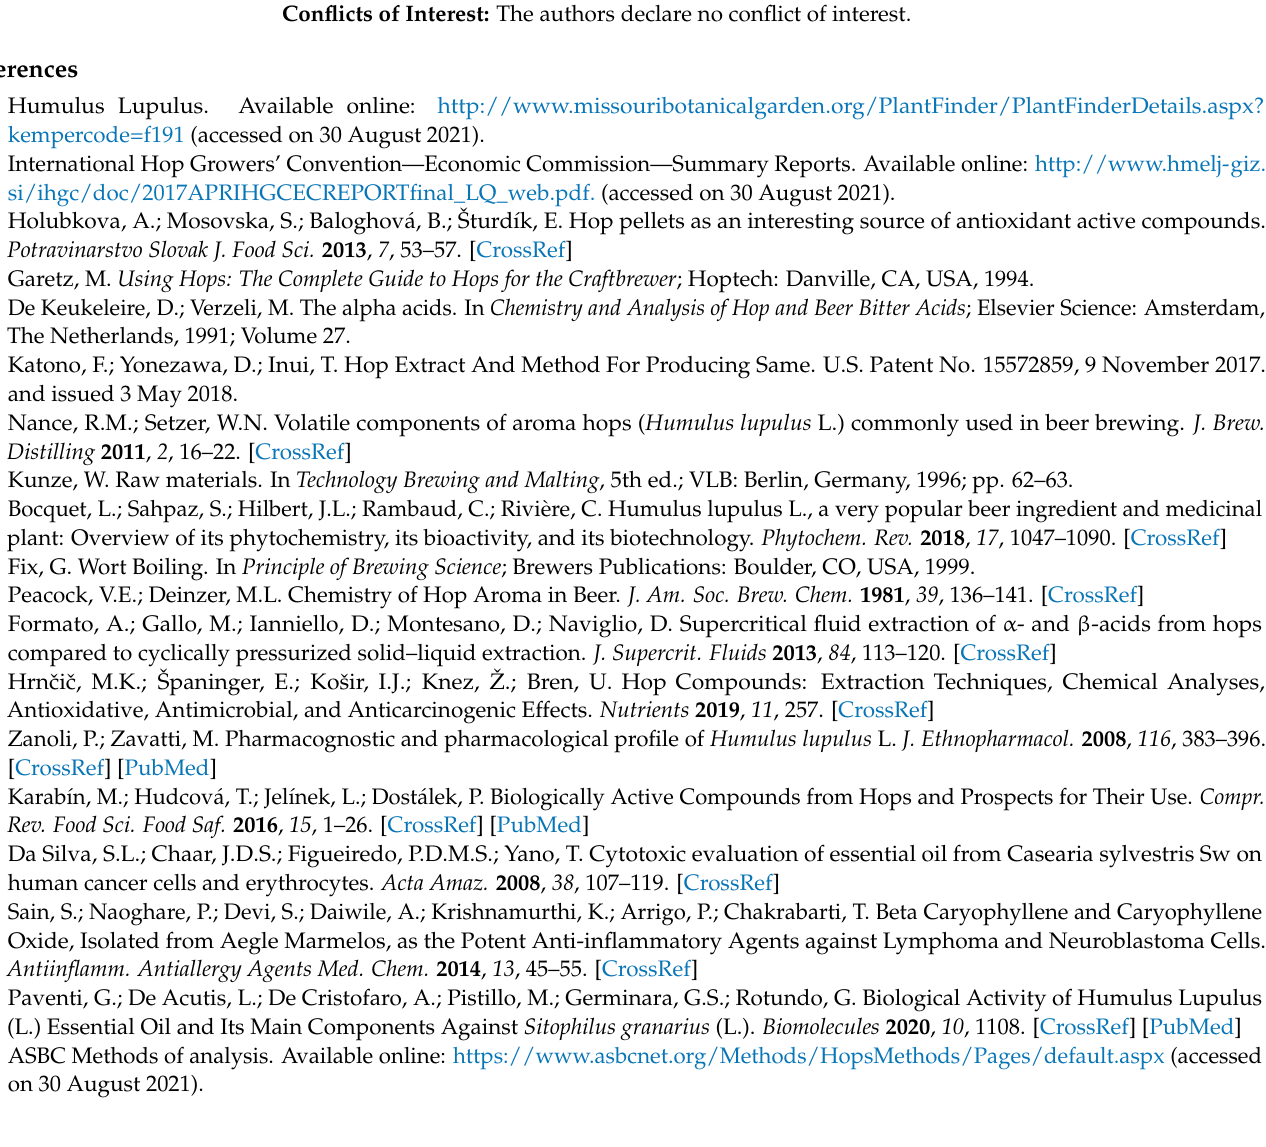
Table S5: MAHD screening summary, Table S6: Energy consumption evaluation. Figure S1: Volatile fraction extraction yields summary, Figure S2: Main terpenoid distribution across MAHD screenings, GC-MS